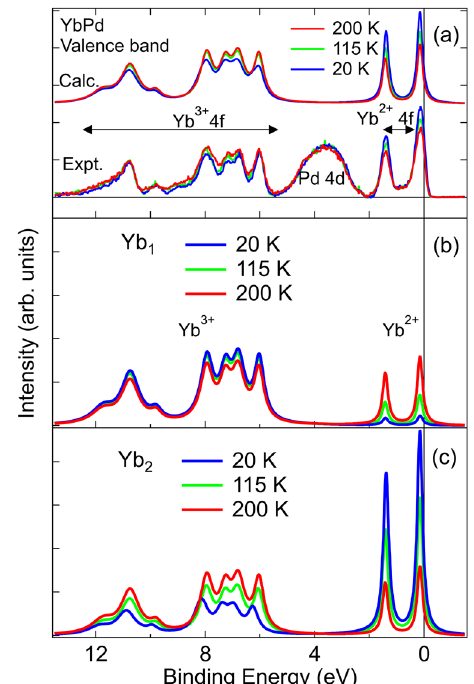
Fig. 3 Con fi rmation of mixed-valence changes in 4f electronic structure. spectra are shown in Supplementary Fig.